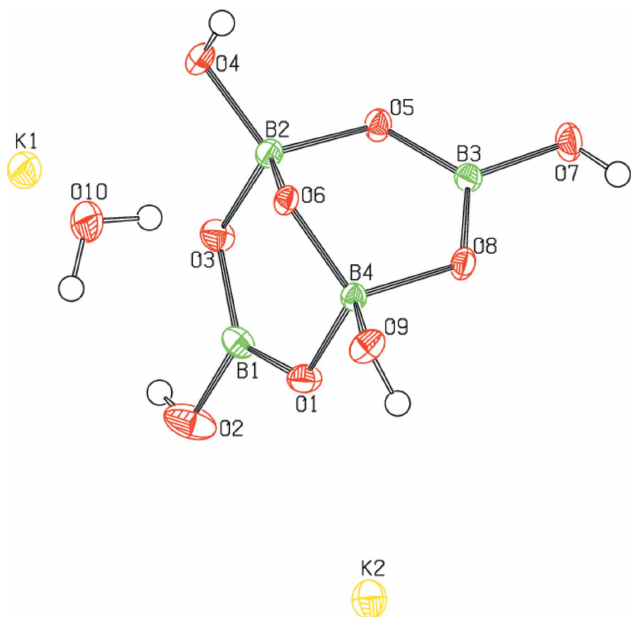
Figure 1 View of the asymmetric unit of (I) with the atom labelling. Displacement ellipsoids are drawn at the 50% probability